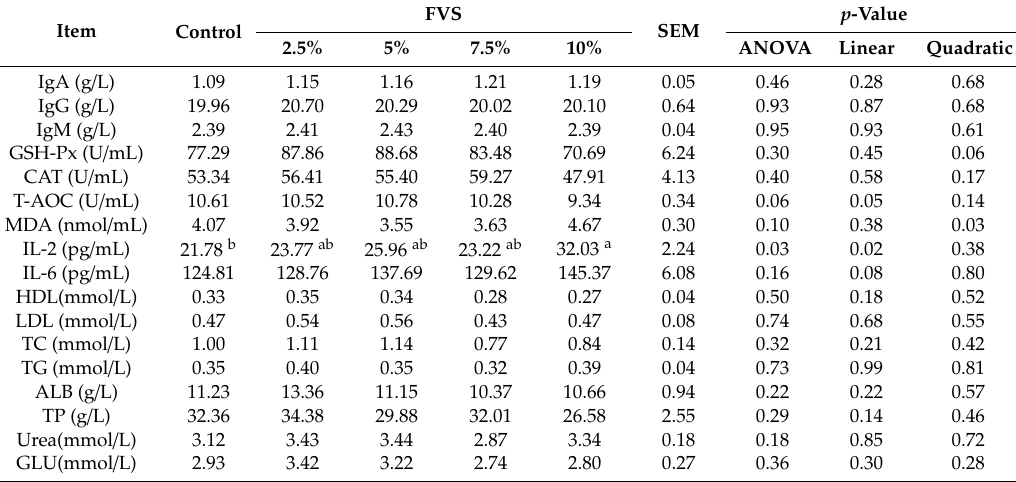
Table 6. E ff ects of dietary Flammulina velutipes stem waste (FVS) supplementation on serum profile of weaned piglets on day 28 (Exp.1).